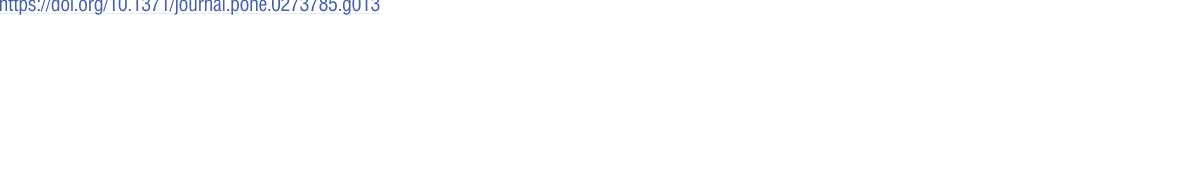
PLOS ONE | https://doi.org/10.1371/journal.pone.0273785 September 14,